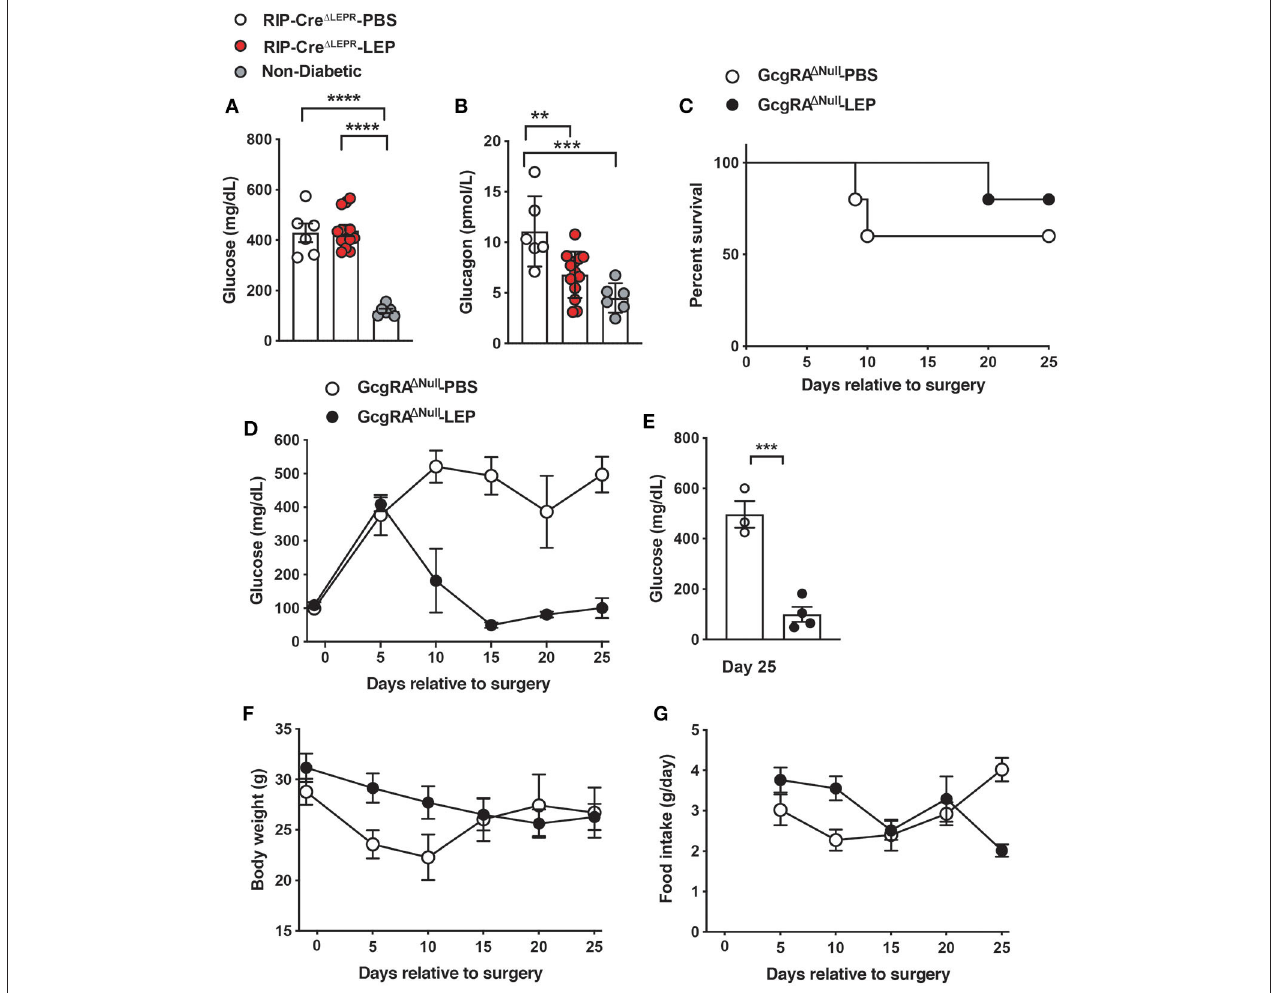
FIGURE 4 | LEPRs in RIP-Cre 25Mgn neurons do not contribute leptin-induced suppression of glucagon secretion in insulin-deficient mice. (A) Blood glucose ( n = 6; RIP-Cre 1 LEPR -PBS, 12; RIP-Cre 1 LEPR -LEP, and 6; Non-diabetic) and (B) plasma glucagon levels ( n = 6; RIP-Cre 1 LEPR -PBS, 13; RIP-Cre 1 LEPR -LEP, and 6; Non-diabetic) in insulin-deficient RIP-Cre 1 LEPR mice 10 days after the induction of chronic administration of leptin into the lateral ventricle (25 ng/0.11 µ L/h). Control group for leptin administration was administered sterile vehicle (PBS). Non-diabetic group was composed of littermate Lepr flox / flox mice that were not administered either i.p. DT or i.c.v. leptin/PBS. (C) The survival percentage ( n = 5; GcgRA 1 Null -PBS and 5; GcgRA 1 Null -LEP at day − 1), (D) the time course of blood glucose ( n = 5; GcgRA 1 Null -PBS and 5; GcgRA 1 Null -LEP at day − 1), (E) blood glucose at Days 25 ( n = 3; GcgRA 1 Null -PBS and 4; GcgRA 1 Null -LEP), (F) the time course of